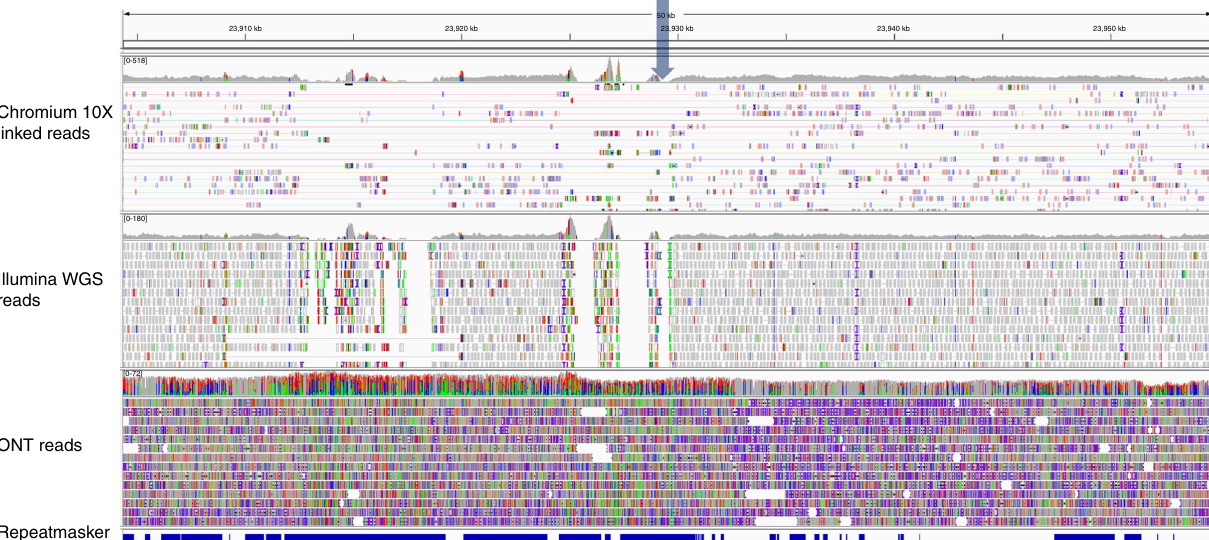
Fig. 4 Close-up view of one inversion breakpoint area on Chromosome 6. A 50 Kbps region is shown, where Tx430 Chromium 10X linked reads, Tx430 Illumina whole genome shotgun (WGS) reads, individual Tx430 ONT reads aligning to the region and RepeatMasker screening output are shown, from top to bottom. The approximate location of the breakpoint area is marked by an